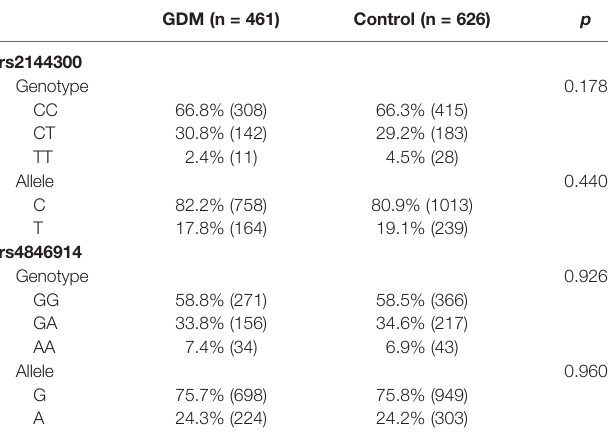
Numbers in parentheses indicate number of subjects with each genotype or number of alleles of each